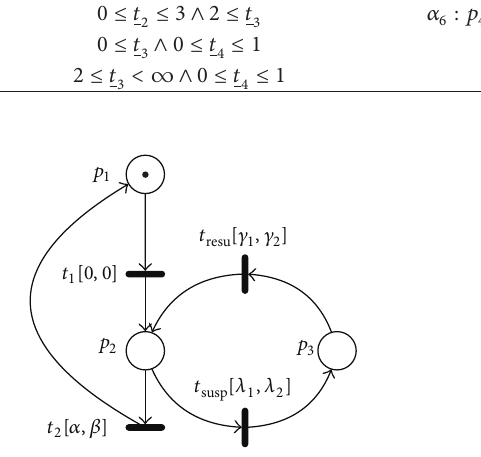
Figure 4: An interruptible task modeled by SWPN, reported from